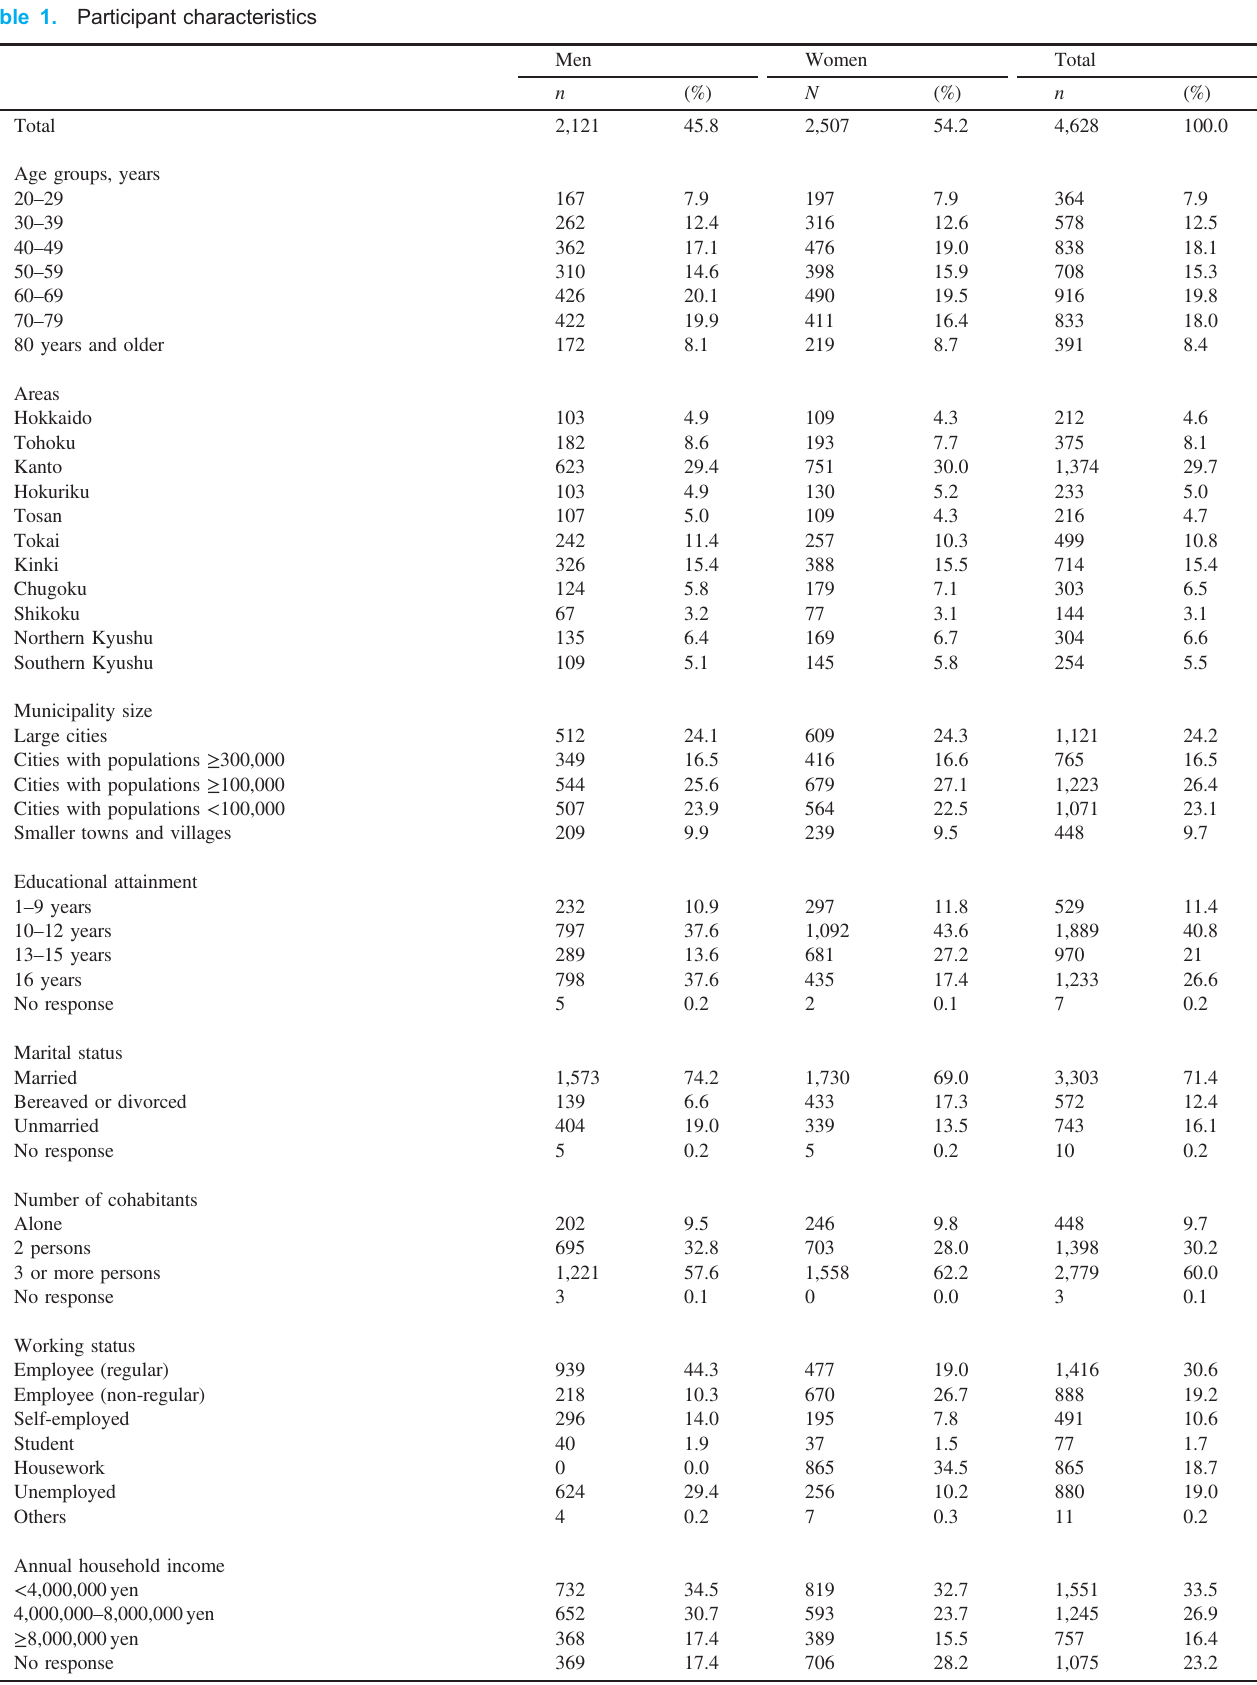
Table 1. Participant